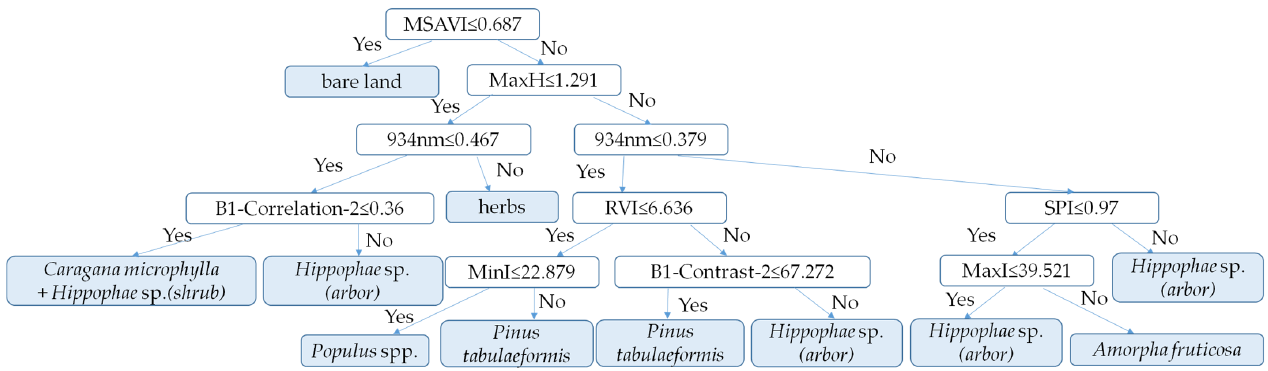
Figure 15. The random forest classifier for classifying trees and shrubs.